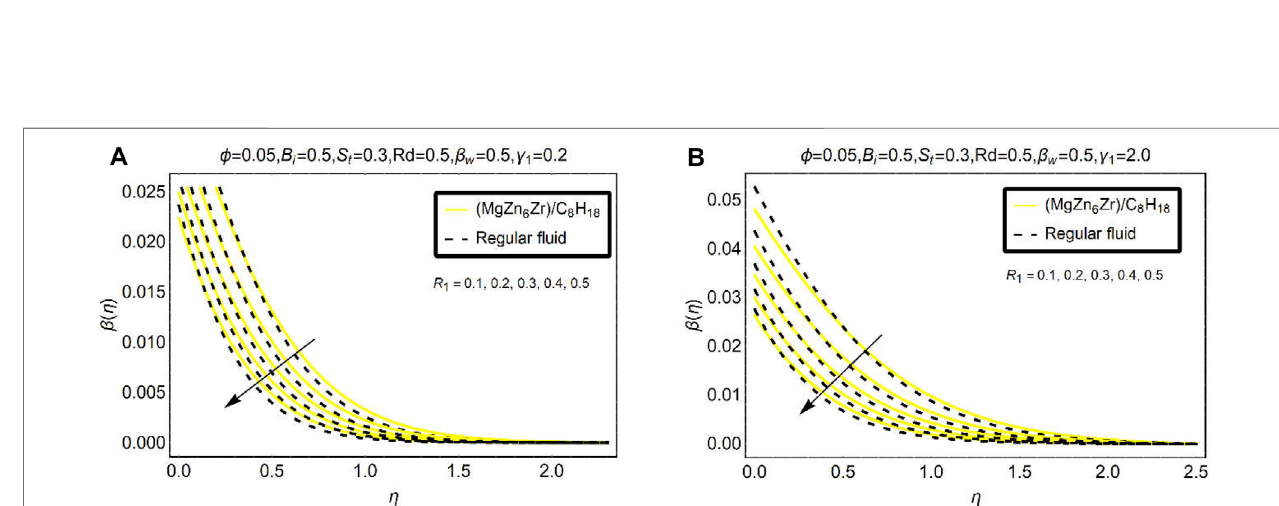
FIGURE 11 | Temperature via R 1 (A) γ 1 (cid:2) 0 . 2 and (B) γ 1 (cid:2) 2 . 0.